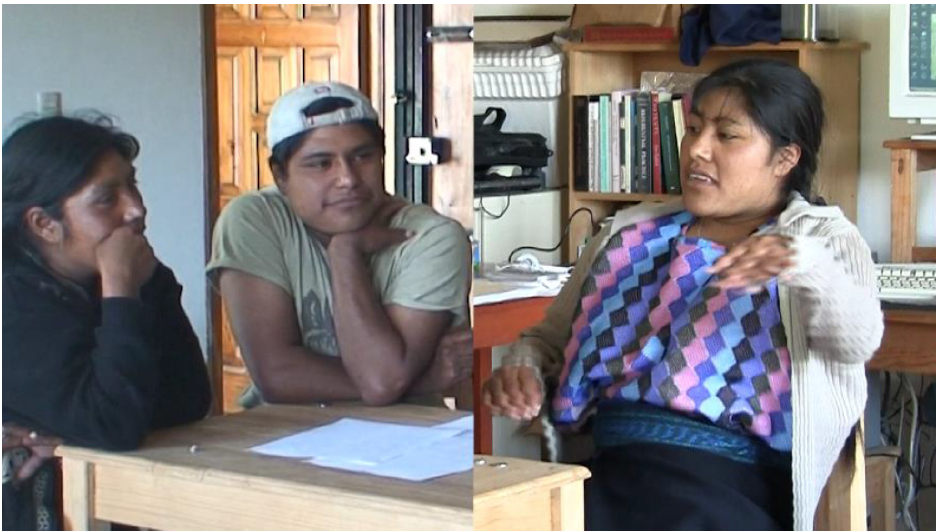
Figure 4. Terry signs HEY2, already having her interlocutors’ attention, and looking away from them at a computer screen.